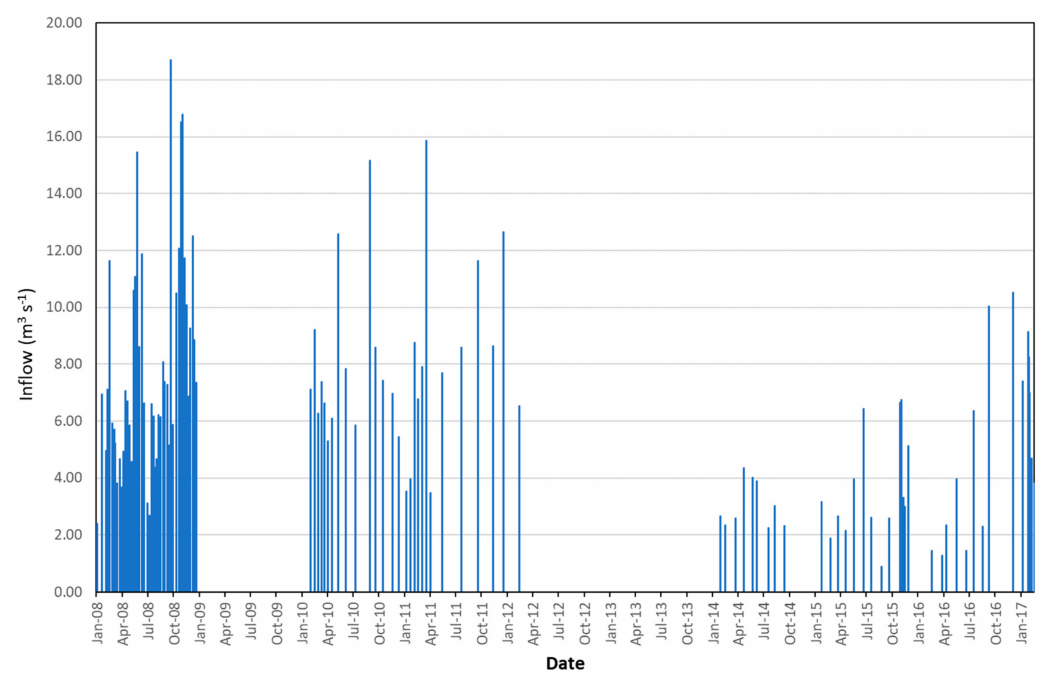
Figure 2. Inflow to the Albufera in each of the sampling